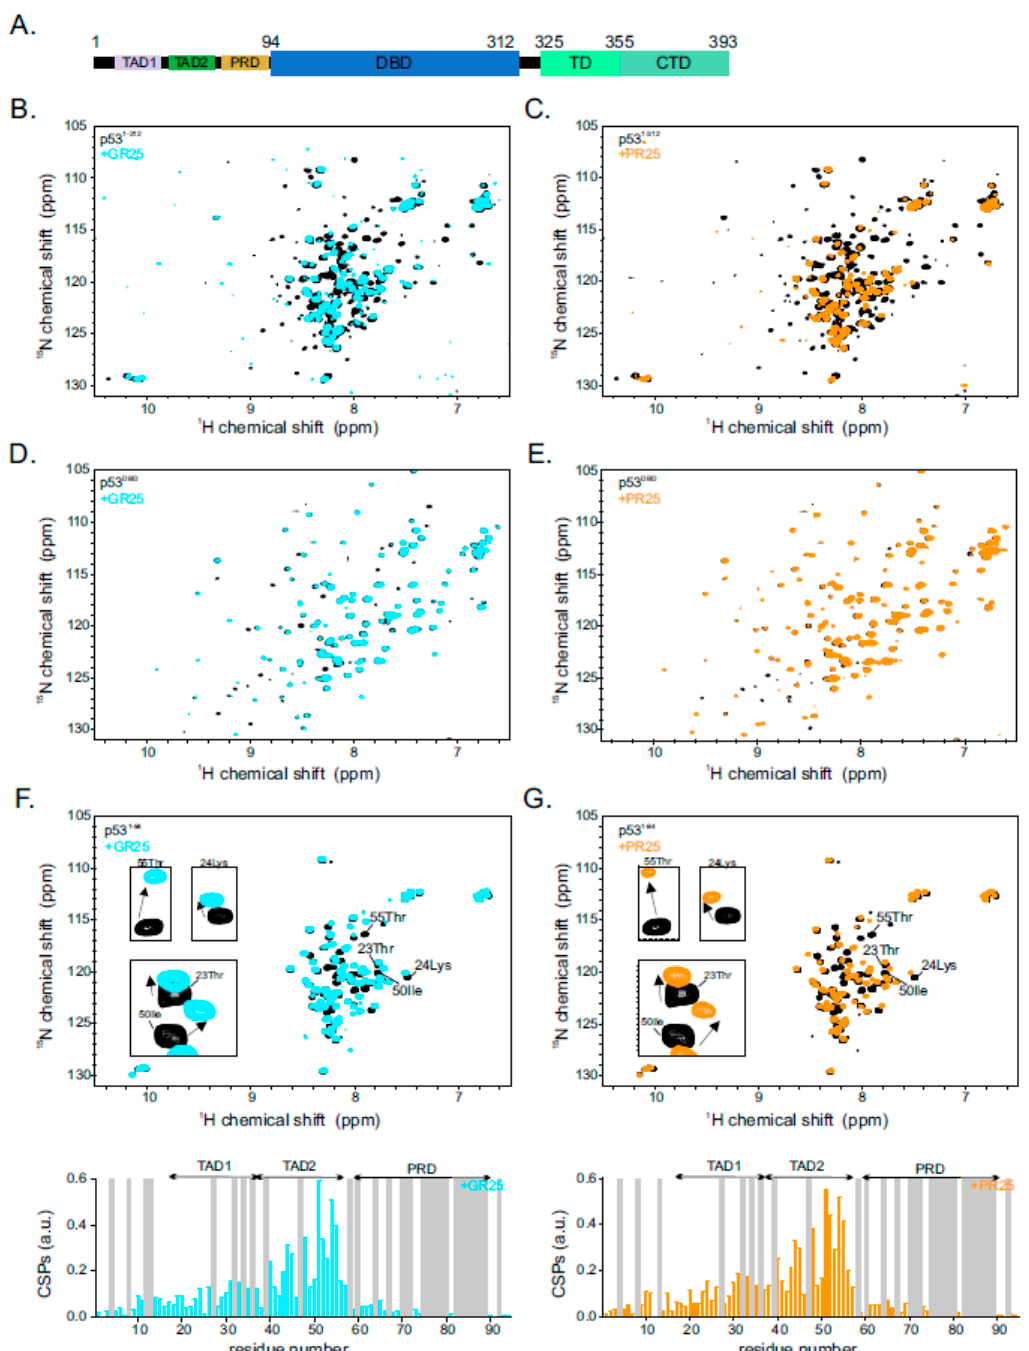
Figure 1. p53 directly interacts with poly-PR/GR dipeptide repeats: ( A ) p53 domain organization including transactivation domain 1 and 2 (TAD1 and TAD2), proline rich domain (PRD), DNA binding domain (DBD), tetramerization domain (TD), and C-terminal domain (CTD); ( B , C ) 1 H- 15 N HSQC spectrum of 15 N-labeled p53 1 − 312 at 50 µ M in the absence (black) or presence of one stoichiometric equivalent of either GR25 (cyan in B ) or PR25 (orange in C ); ( D , E ) 1 H- 15 N HSQC spectrum of 15 N-labeled p53 DBD at 50 µ M in the absence (black) or presence of one stoichiometric equivalent of either GR25 (cyan in D ) or PR25 (orange in E ); ( F ) 1 H- 15 N HSQC spectrum of 15 N-labeled p53 1 − 94 at 50 µ M in the absence (black) or presence of one stoichiometric equivalent of GR25 (cyan; upper panel). Corresponding chemical shift perturbations (CSPs) of the 1 H- 15 N HSQC p53 1 − 94 cross-peaks are shown in a bar-plot at the bottom panel; ( G ) 1 H- 15 N HSQC spectrum of 15 N-labeled p53 1 − 94 at 50 µ M in the absence (black) and presence of one stoichiometric equivalent of PR25 (orange; upper panel). Corresponding CSPs are shown in a bar plot at the bottom panel. Unassigned residues are indicated in grey.